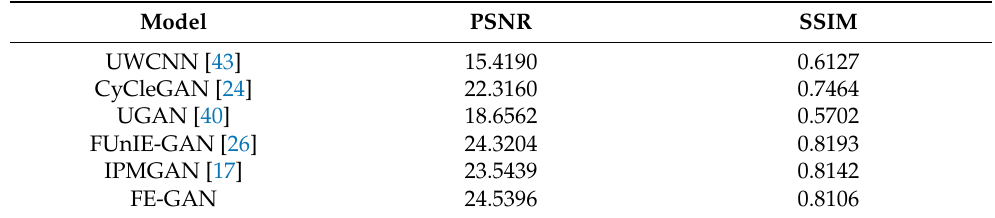
Table 2. Quantitative comparison results with the state-of-the-art methods in the ImageNet dataset. Model PSNR SSIM UWCNN [43]